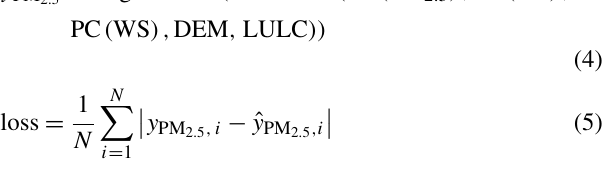
gridded dataset is constructed for three observational vari- ables, denoted as PC ( PM 2 . 5 ) , PC ( RH ) , and PC ( WS ) . By binding PointConv results of different variables of PM 2 . 5